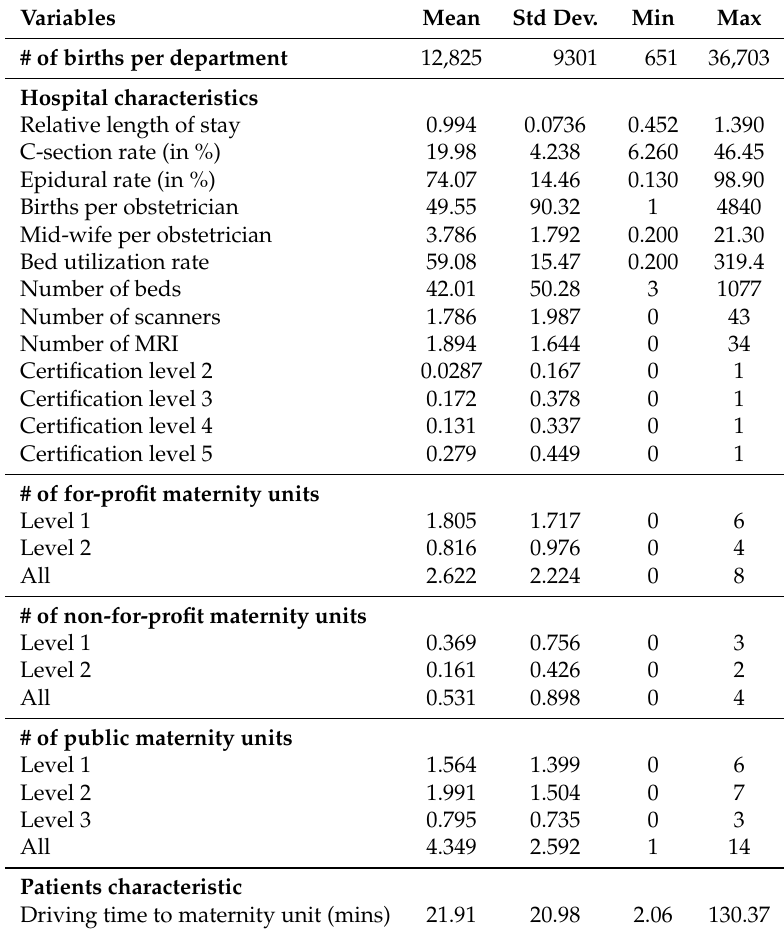
Table 1. Maternity units summary